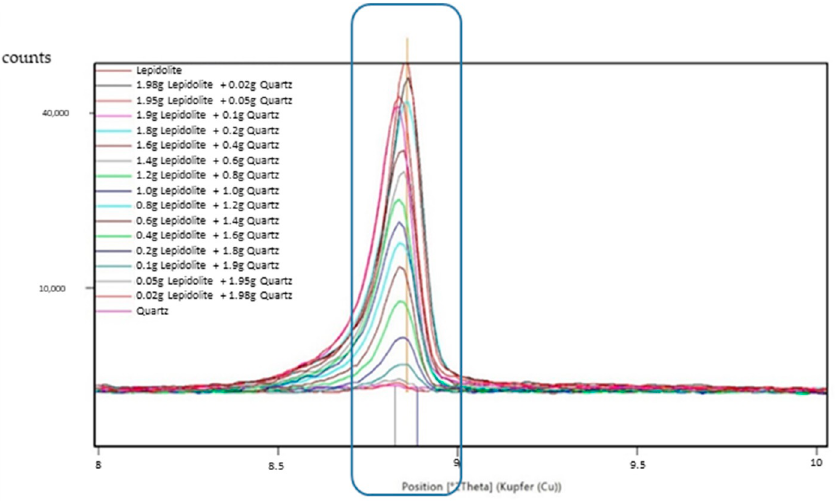
Figure 20. Details of XRD patterns showing main peak of lepidolite in different contents.